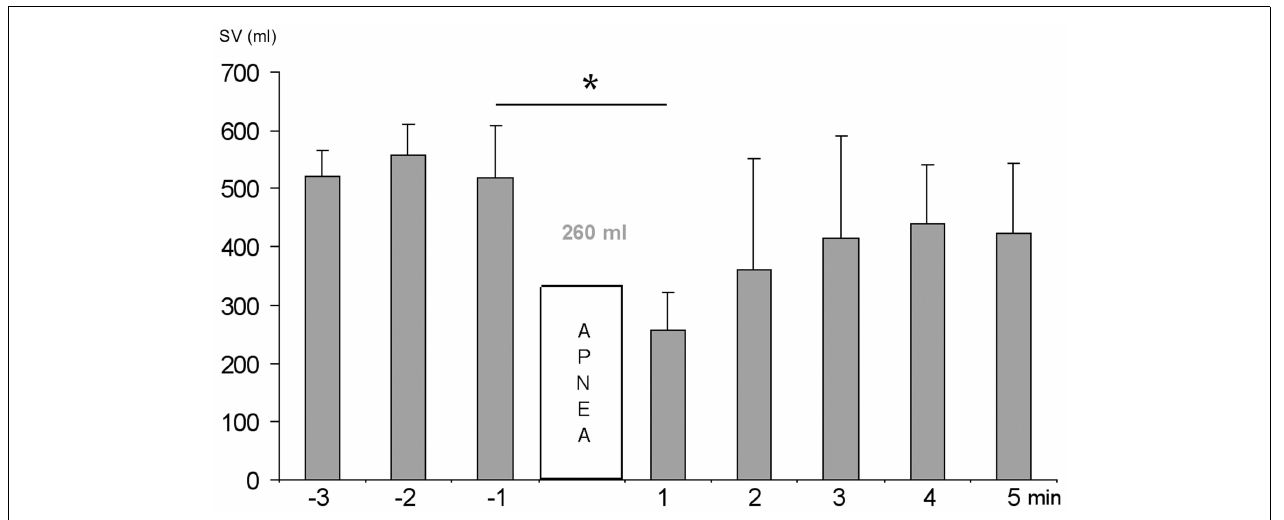
FIGURE 3 | Minute to minute mean (SD) spleen volume (SV) before and after 2min apnea in the three highest scoring divers. Significance at P < 0.05 is indicated by *.